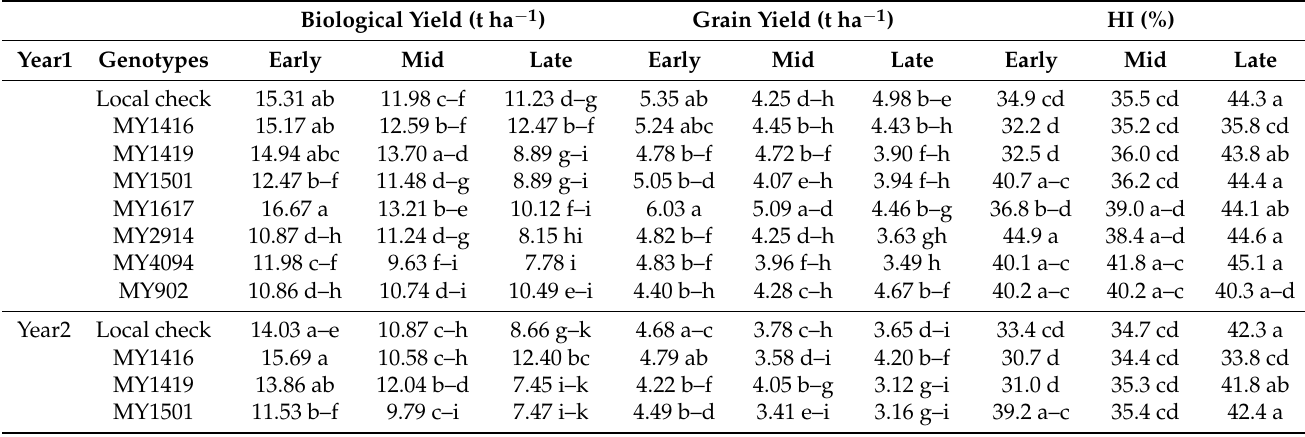
Table 7. Biological and grain yields and harvest index of different wheat genotypes grown under the semi-arid climate of northern